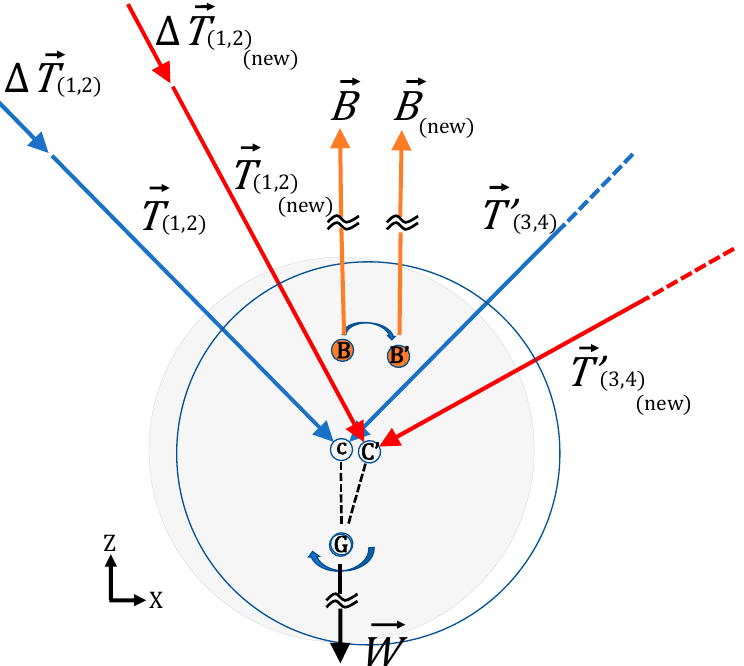
∆ t ) : Balanced thrust increase with resulting pitch. Figure 6. Case 2 (𝑡 + ∆𝑡) : Balanced thrust increase with resulting pitch. Figure 6. Case 2 ( t + The body of the sphere rotates clockwise about G. The new position of the geometric center and center-of-buoyancy are denoted as C’ and B’, respectively. Note the changes (cid:42) (cid:42) + ∆ T ( T ( to the corresponding thrust vectors. is now less effective in generating 1,2 ) 1,2 ) (cid:42) T (cid:48) ( + x translation and more prone to pushing the sphere down, while has become less 3,4 ) effective at pushing the sphere down and more effective at resisting + x translation. The change in forces, from the reference frame of the sphere, is given in Figure